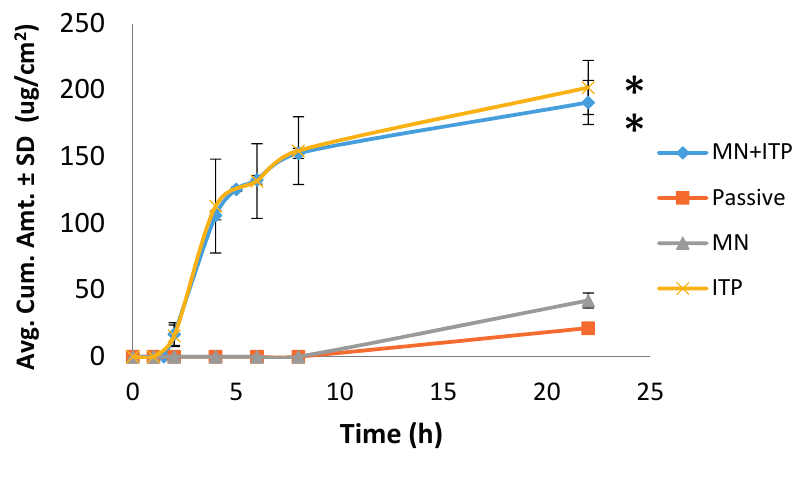
Figure 1. Comparison of glycopyrrolate permeation with passive and active